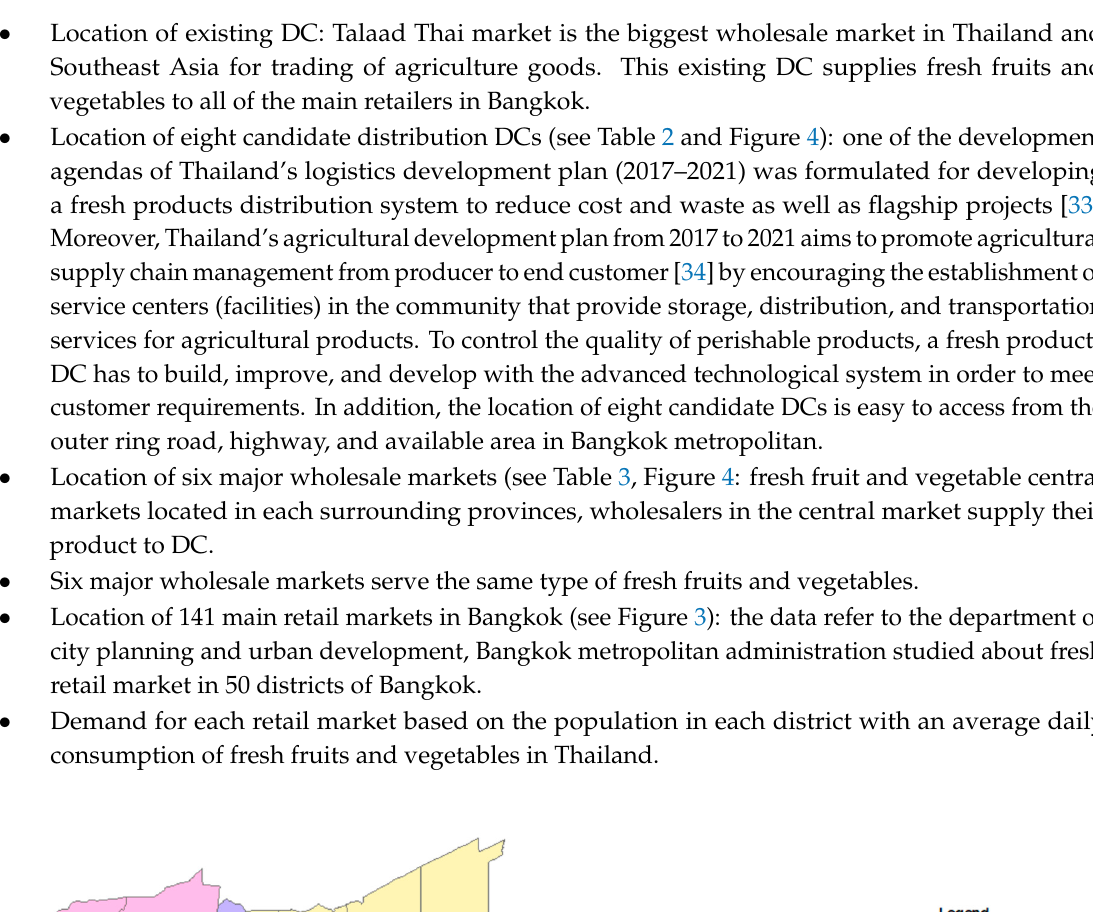
Table 3. Wholesale market of six provinces around Bangkok area.